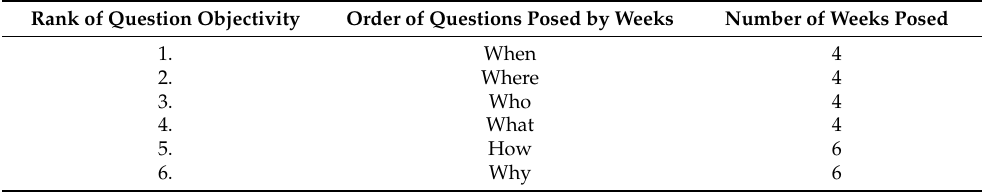
Table 2. The order of each of the six type of questions (from most objective to most subjective) in how they posed over the weeks during the academic year at the HeNReG meetings and the number of weeks each type of question is the